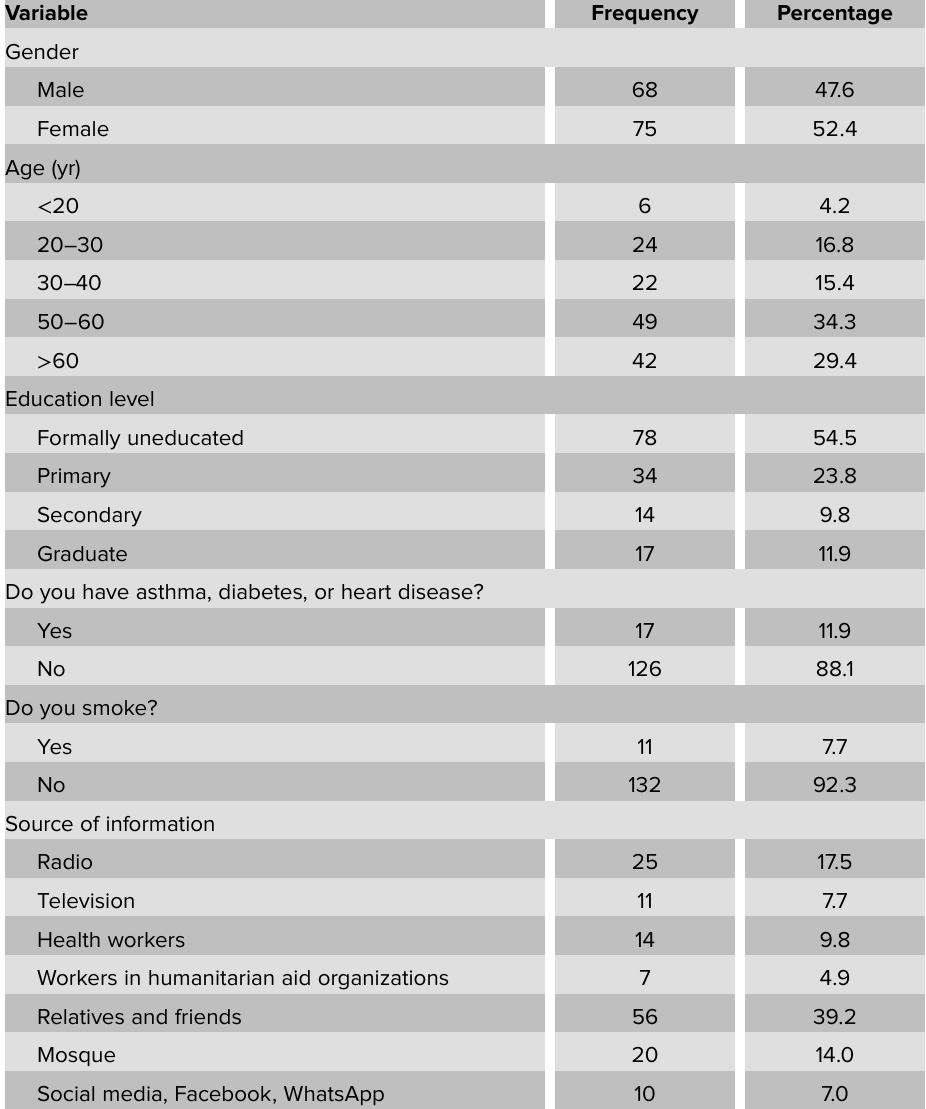
TABLE 1: Distribution of demographic characteristics of the participants ( n =